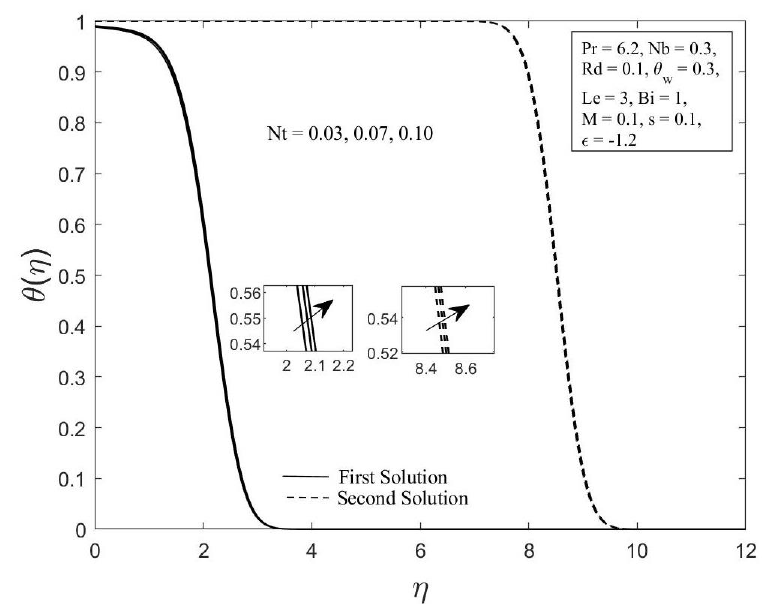
Figure 8. The temperature profile 𝜃(𝜂) for diverse values of 𝑁𝑡 .